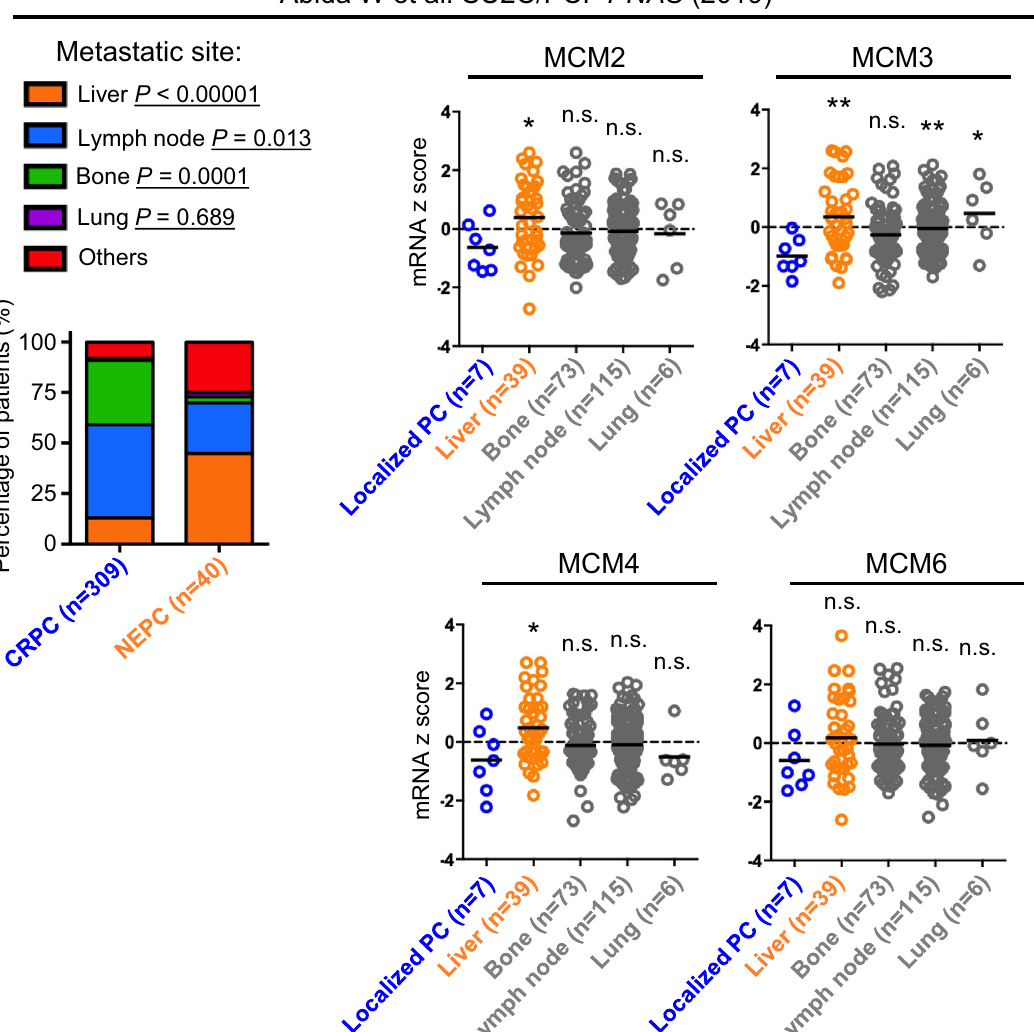
Figure 2. Elevated levels of MCM2/3/4 are associated with liver metastasis. ( A ) Metastatic incidence by sites from CRPC and NEPC from SU2C/PCF dataset 18 was plotted as percentage of patients. The p values of the proportion differences of metastatic sites between CRPC and NEPC were calculated by z-score test for two population proportions. ( B ) Relative mRNA expression levels of MCM2/3/4/6 in different metastatic sites including liver, lymph node, bone, and lung from SU2C/PCF dataset 18 are shown. * p < 0.05, ** p < 0.01, and n.s. = not significant, determined by Student’s t test between localized prostate cancer with metastatic